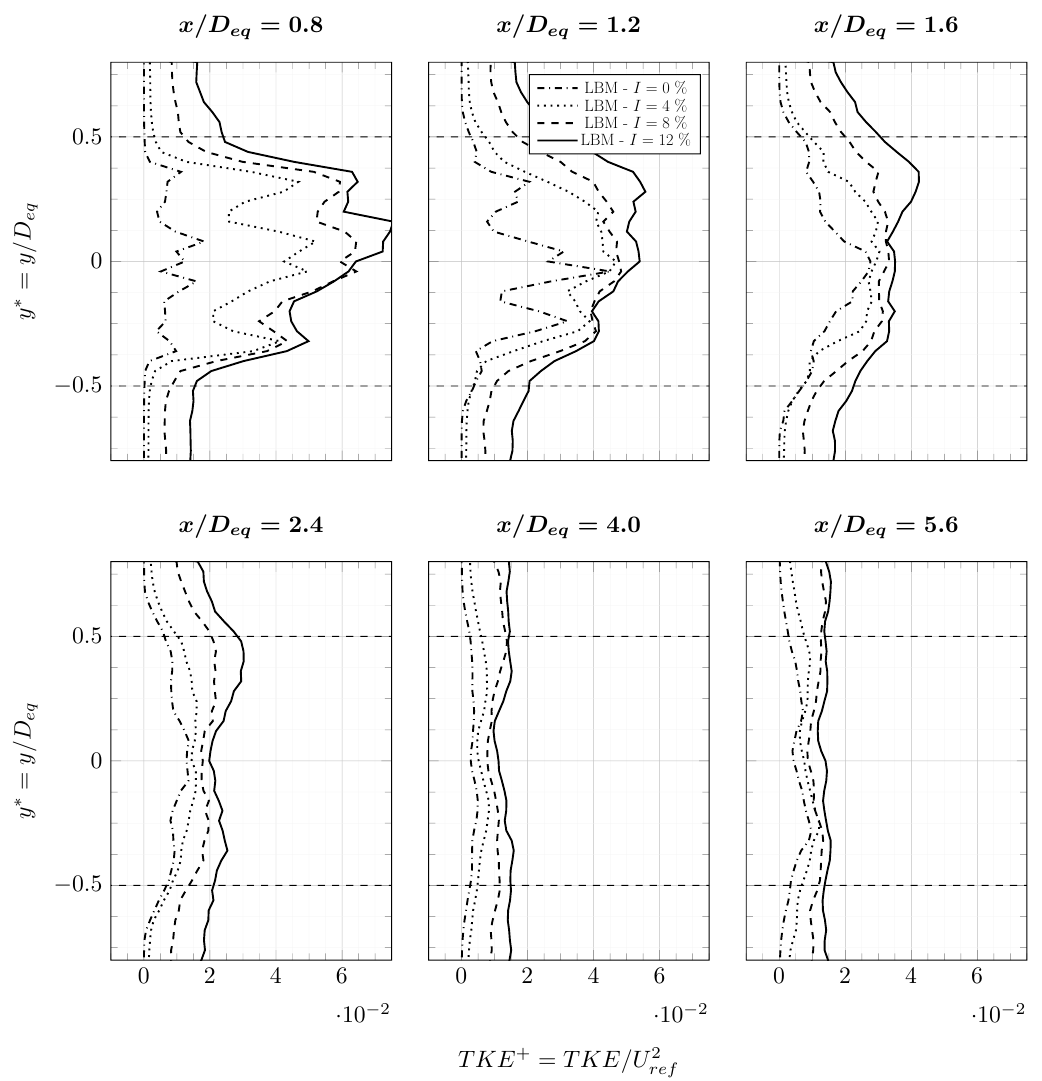
Figure 19. Average TKE + y profiles in the wake of the tidal turbine at TSR = 1.5. Horizontal profiles extracted at the turbine mid-height. ALM-LBM results for the four turbulence rates. Turbine footprint is drawn in horizontal black dashed lines. Dimensions are scaled by the equivalent diameter D eq = 25.0